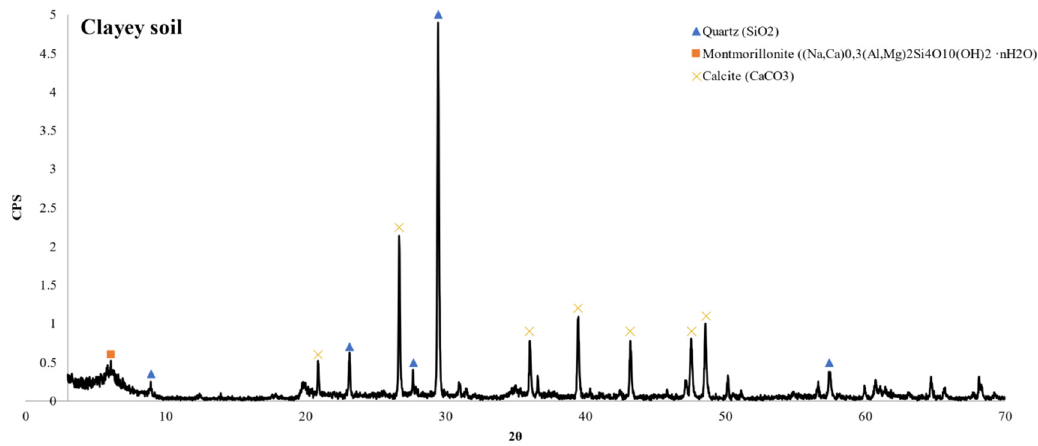
Figure 3. XRD of clayey soil.